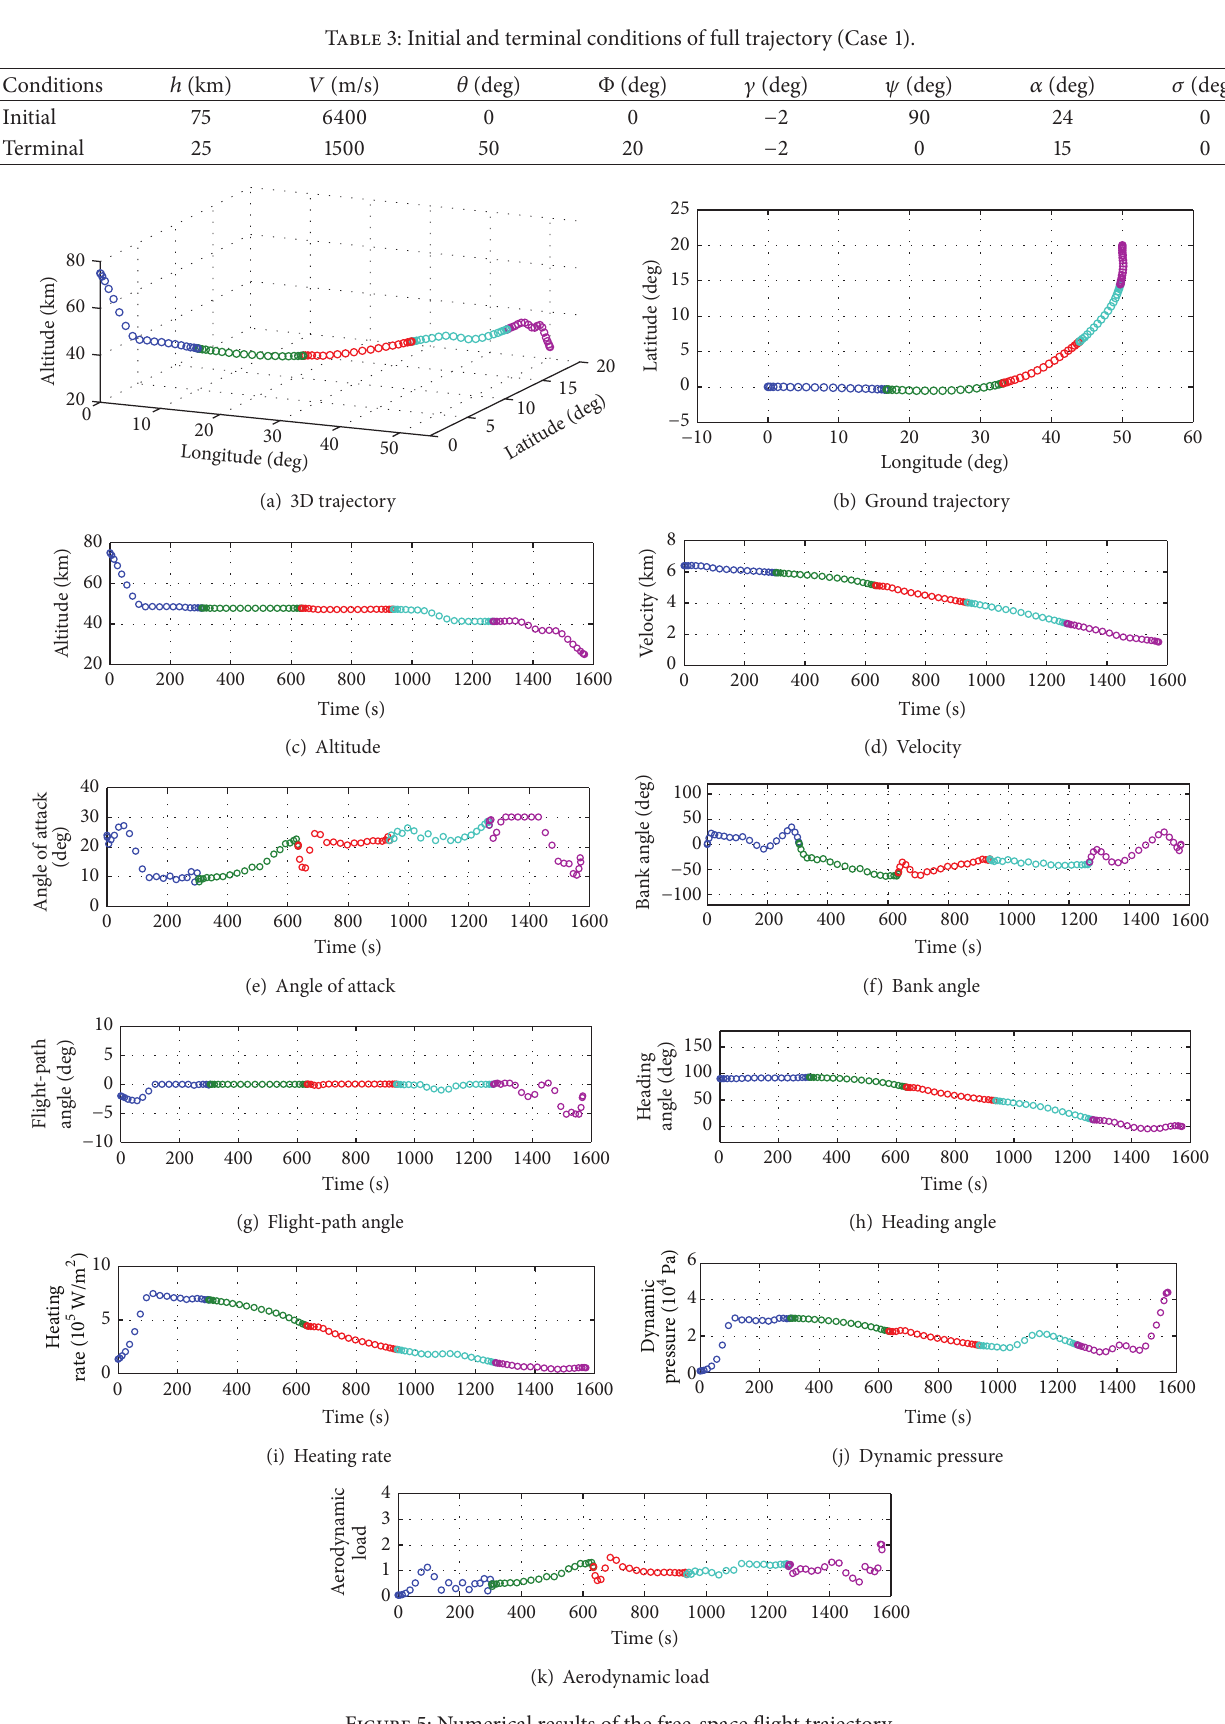
Figure 5: Numerical results of the free-space flight